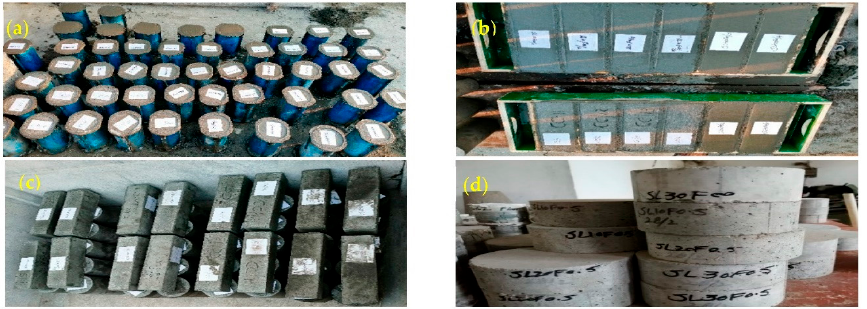
Figure 2. ( a ) Cast cylindrical specimens, ( b ) cast prisms for flexural strength test, ( c ) demolded prisms and cylinders, ( d ) concrete discs obtained by the cutting of cylinders for the performance of the drop weight impact test.